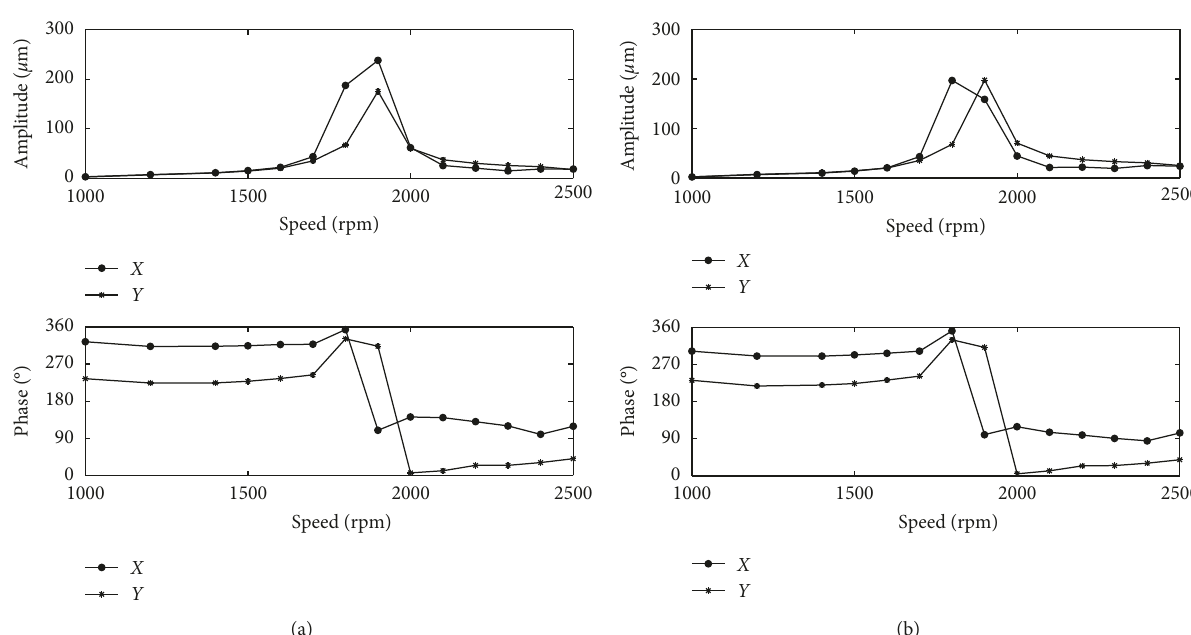
Figure 3: The vibration response of measuring planes A and B. X and Y correspond to the horizontal and vertical direction, respectively. (a) Vibration response of measuring plane A. (b) Vibration response of measuring plane